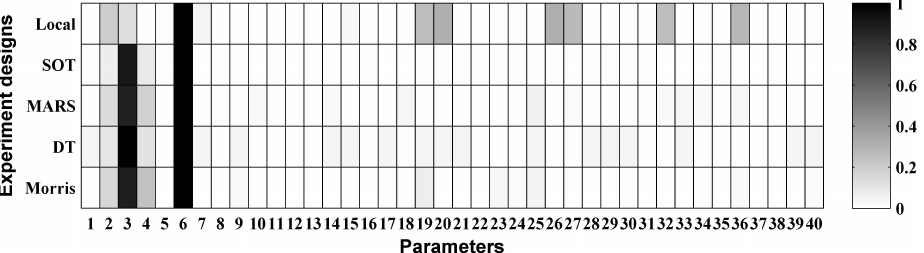
Fig. 11. The qualitative sensitivity analysis results of different methods for soil moisture. The sensitivity scores are normalized to [0, 1]; 1 means most sensitive and 0 means least